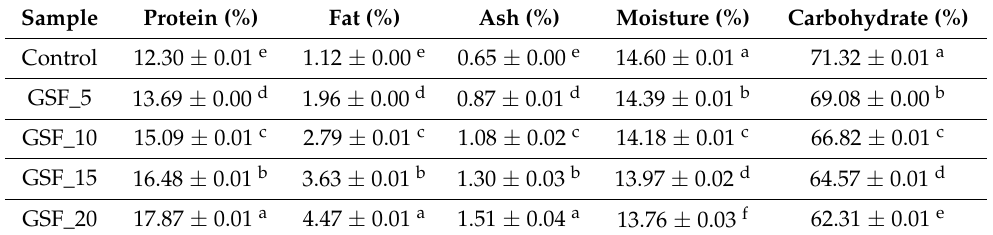
Table 1. Chemical characteristics of composite flours with different proportions of GSF supplementation [33].